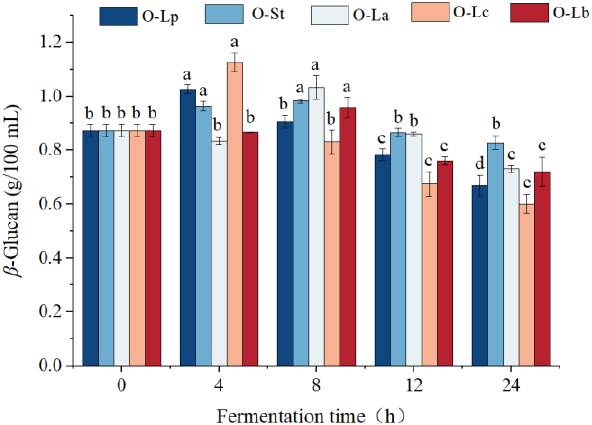
Figure 2. Changes of β -glucan content in oats fermented by different strains at different times. Different letters indicate significant differences among different fermentation time a given fermentation strain ( p < 0.05). O-Lp, sample fermented with L. plantarum ; O-La, sample fermented with L. acidophilus ; O-Lc, sample fermented with L. casei ; O-Lb, sample fermented with L. bulgaricus ; O-St, sample fermented with S. thermophilus . h, hours.